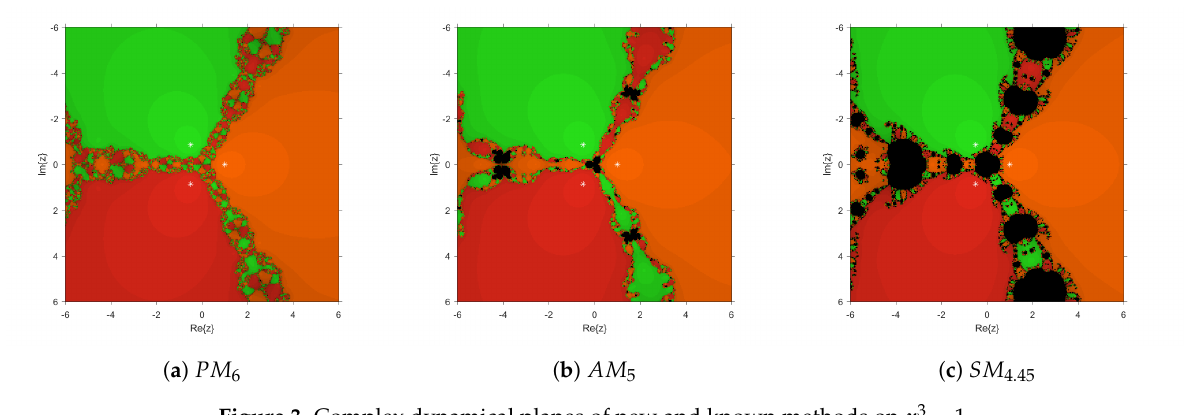
Figure 3. Complex dynamical planes of new and known methods on x 3 − 1.